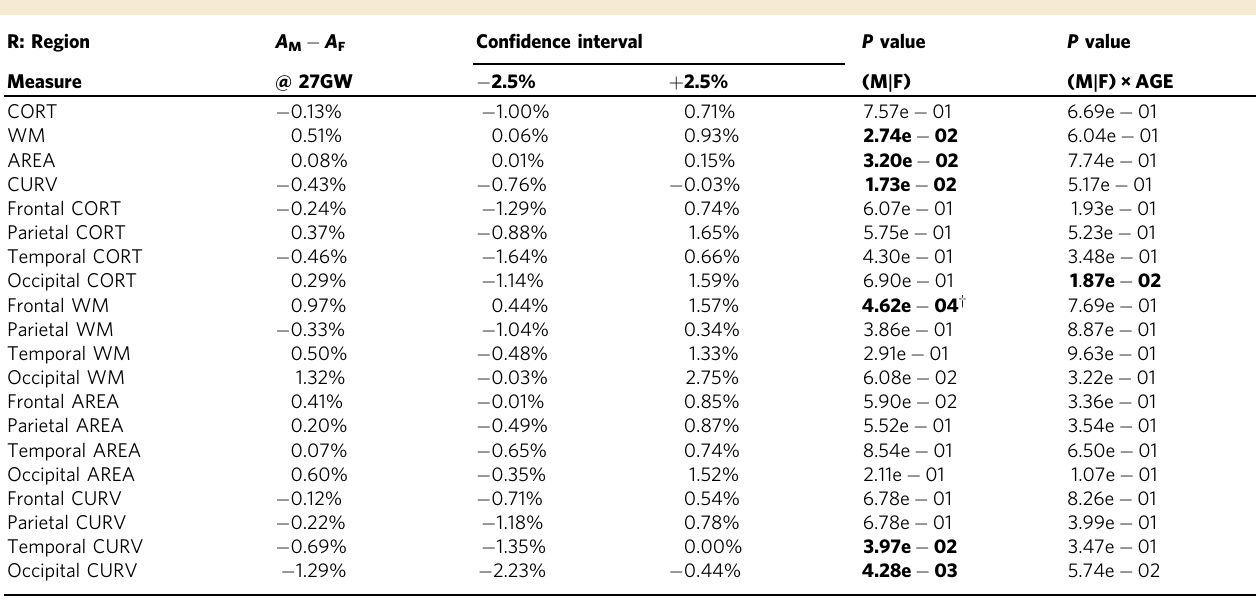
Table 3 Differences in trajectories of brain asymmetry.